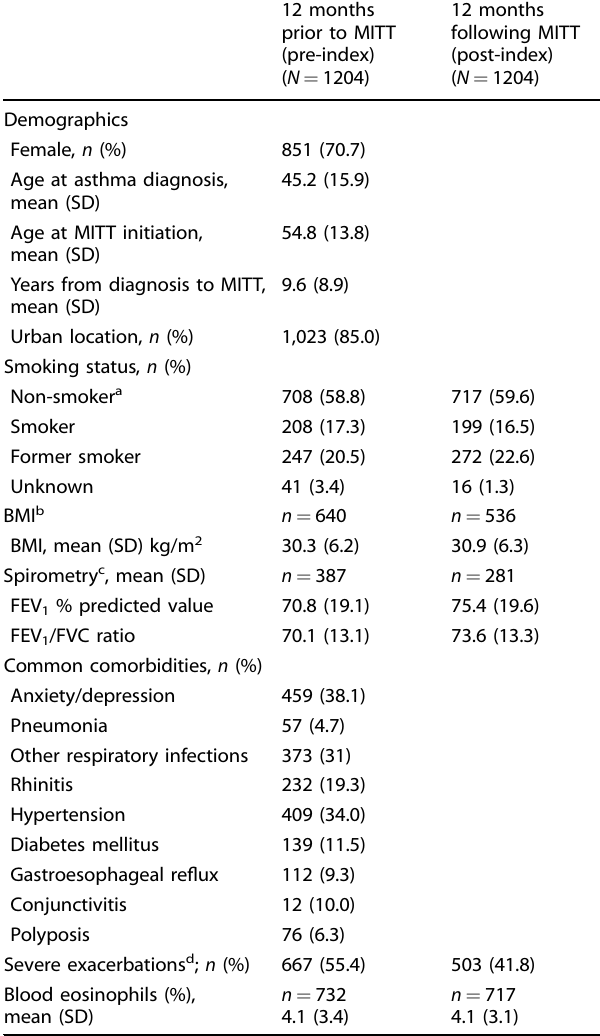
Table 1. Demographics and clinical characteristics 12 months prior to and 12 months following MITT